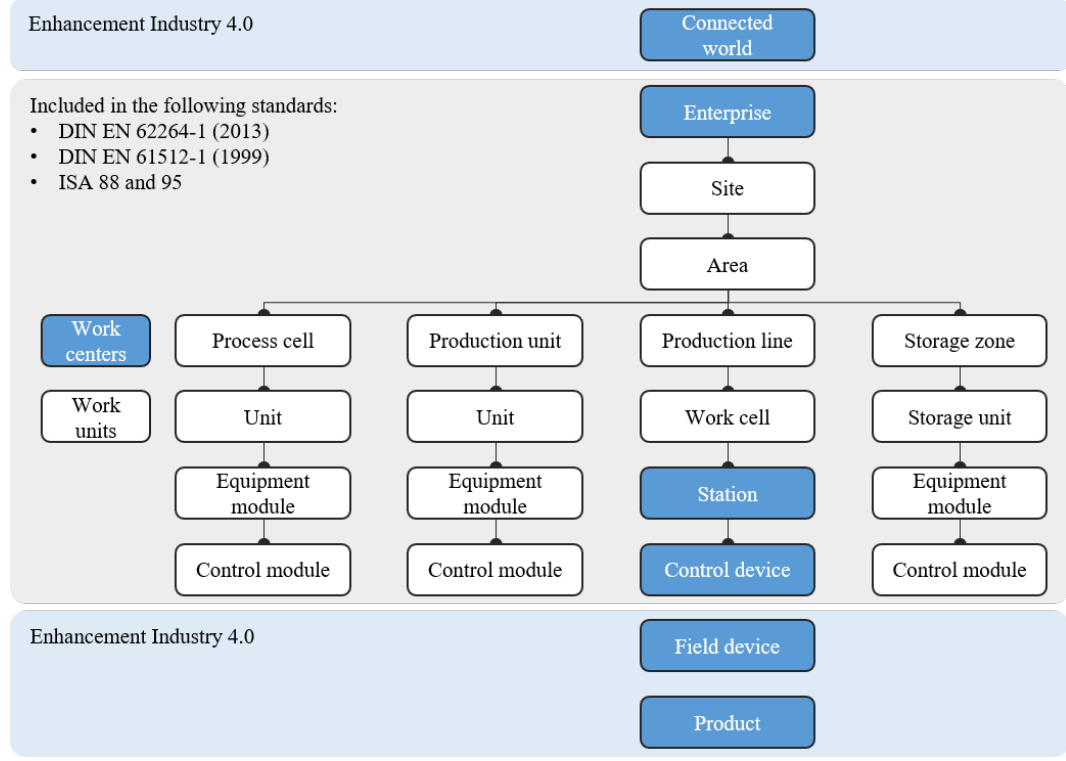
Figure 3. Hierarchical levels of RAMI4.0 adapted from